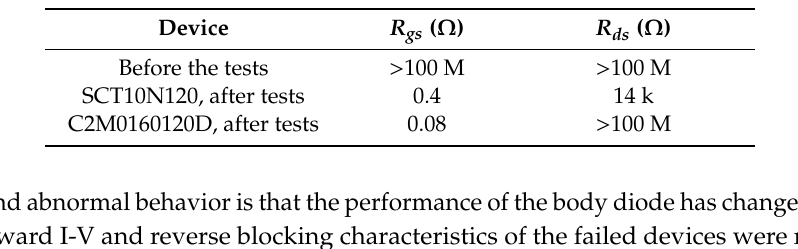
Table 4. Measured resistances between electrodes before and after surge tests.